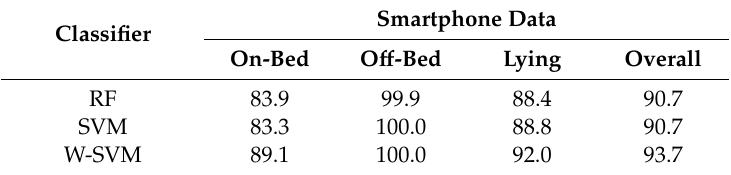
Table 3. Overall performance and performance by class using di ff erent classifiers on Smartphone data.